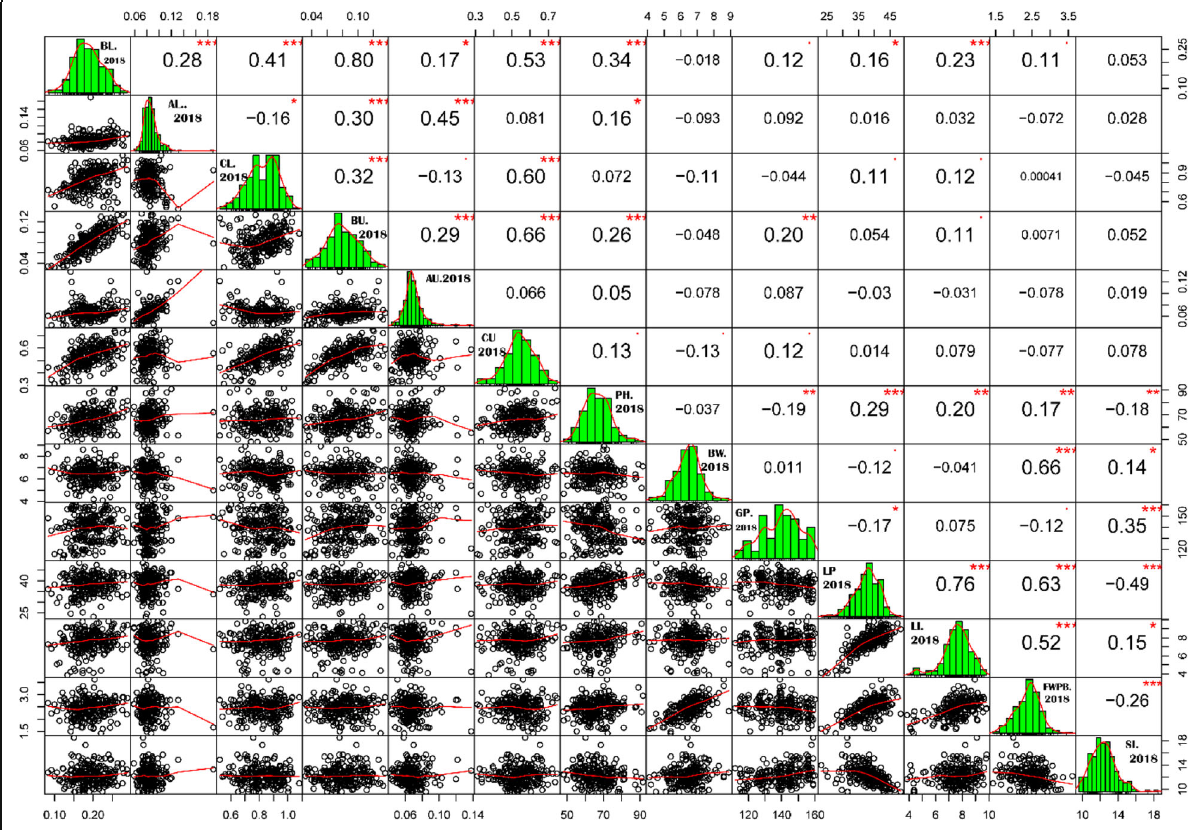
Fig. 2 Frequency distribution of phenotypic variation of six-stem hardness related traits and seven yield-related traits and correlation coefficients among the traits in 237 accessions. BL: bending lower; AL: acupuncture lower; CL: compression lower; BU: bending upper; AU: acupuncture upper; CU; compression upper: PH: plant height; BW: boll weight; GP: growth period; LP: lint percentage; LI: lint index; SI: seed index index; FWPB: flower weight per boll. *, **, ***: significant at P = 0.05, P =0.01, P =0.001,